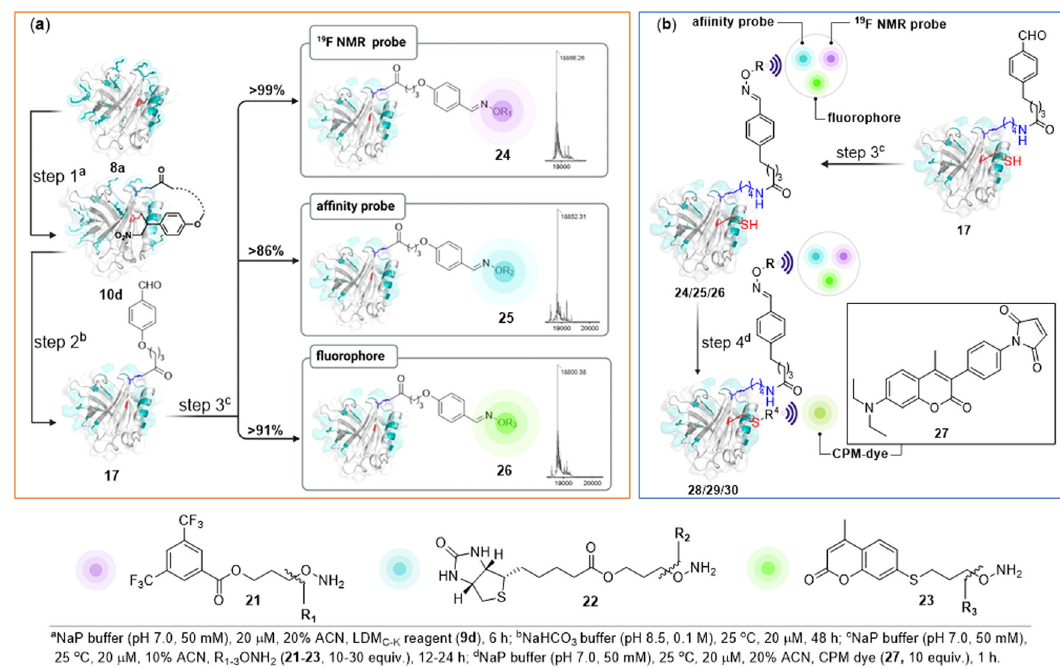
Fig. 6 | Late-stage installationofvarious tags onprotein. a Single-site parallel installation of 19 F NMR probe 21 , af fi nity probe 22 , and fl uorophore 23 . b Precise second probe installation through the chemoselective installation of CPM dye ( 27 ) on protein bioconjugates ( 24 – 26 ) to render dual-probe conjugates ( 28 – 30